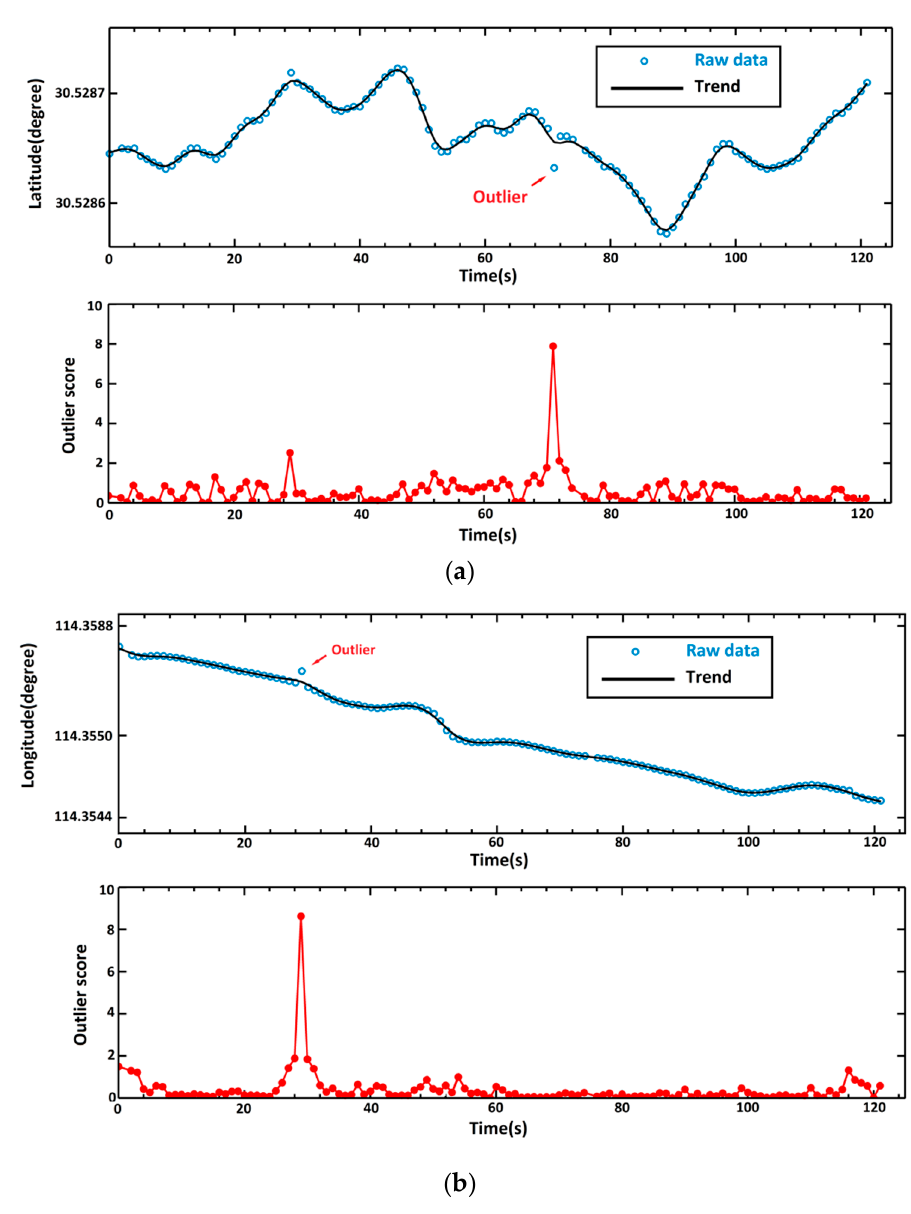
Figure 2. Determined trend of the trajectory (shown in Figure 1) and the outlier score for each observation in ( a ) latitude direction and ( b ) longitude direction.